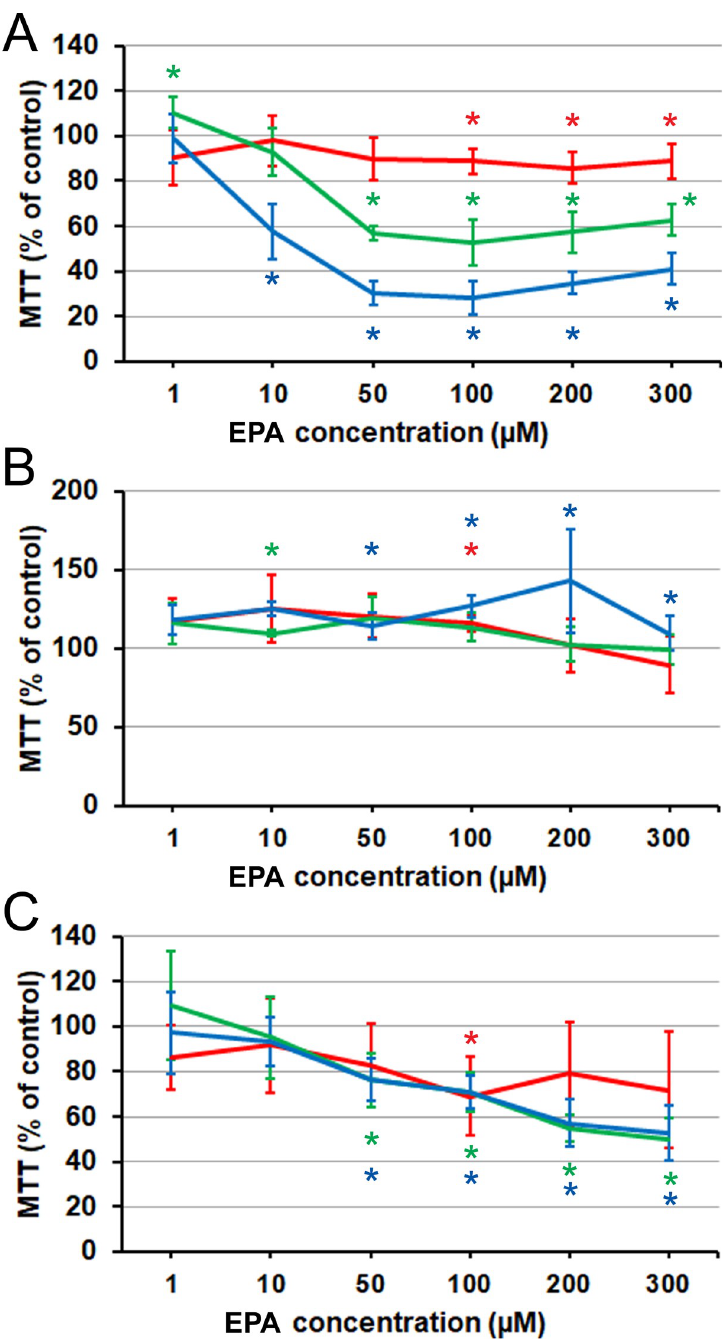
Fig 2. Effect of EPA on prostate cancer cells proliferation and viability as measured by MTT assay. (A) PC3 cells. (B) LNCaP cells. (C) C4-2 cells. Red line: 24 h. Green line: 48 h. Blue line: 72 h. Error bars: standard deviation. Asterisk: difference from the control is significant on the significance level 0.05, corrected for multiple comparisons. PC3 and C2-4 data: each point is the average of n = 9 cell cultures. LNCaP data: each point is the average of n = 6 cell